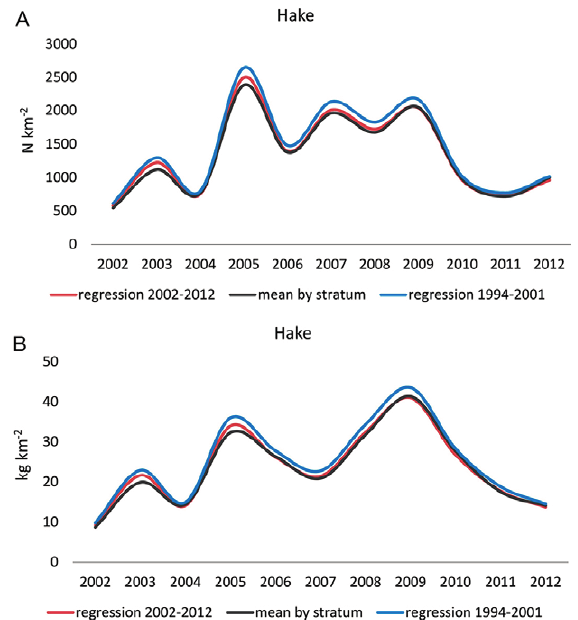
Fig. 2. – Comparison of the abundance indices (A, abundance in N km –2 ; B, biomass in kg km –2 of European hake) as means by stratum, obtained with the values of wing opening per haul esti- mated from the SCANMAR monitoring system and as results of two logarithmic regressions respectively for the years 2002- 2012 and for the years 1994-2001: WO =14.54+0.651×ln( x ); WO =6.7873×ln( depth )+133.94, where WO is the wing opening and x is depth.